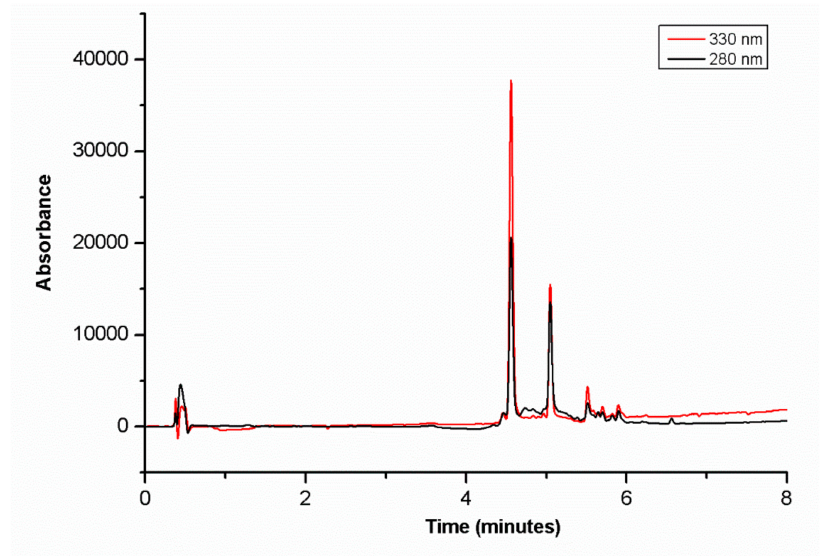
Figure 1. Chromatographic analysis of blueberry (BB) extract by UHPLC / MS / MS. The chromatogram was registered at 280 nm (black line) and 330 nm (red